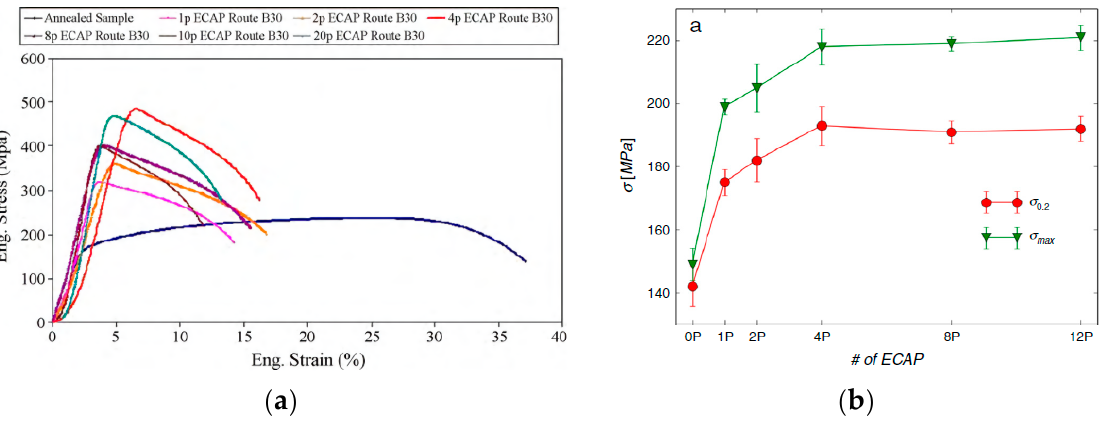
Figure 8. ( a ) Stress –strain plot varying different number of passes in the B 30 route using copper; and ( b ) Yield and tensile strength graph that changes depending on the number of passes [74,78].